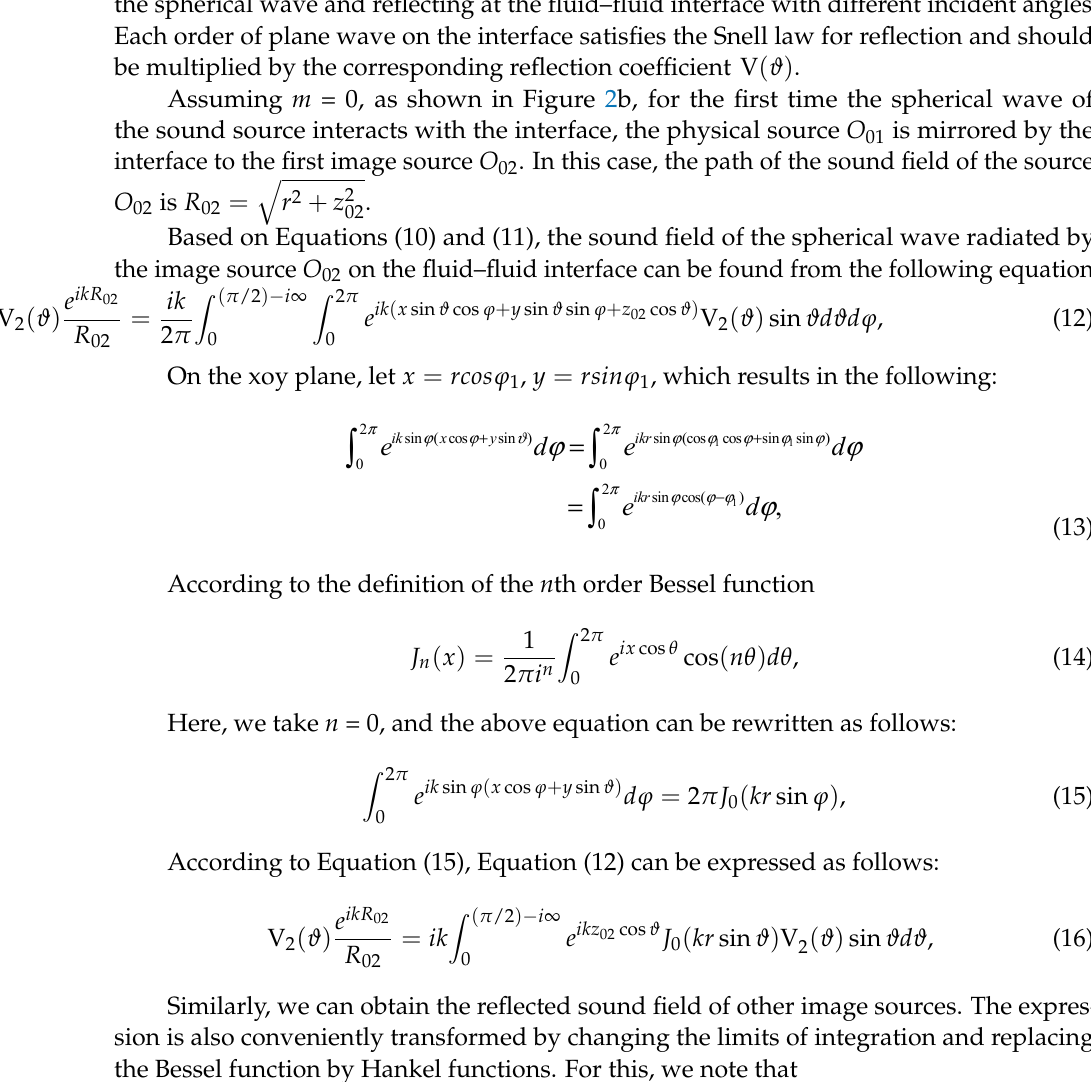
Figure 2. Diagram of the interaction between plane wave and liquid–liquid interface: ( a ) decompo- sition of the wavenumber vector k in three-dimensional (3D) space; ( b ) sound reflection of plane waves on the liquid–liquid